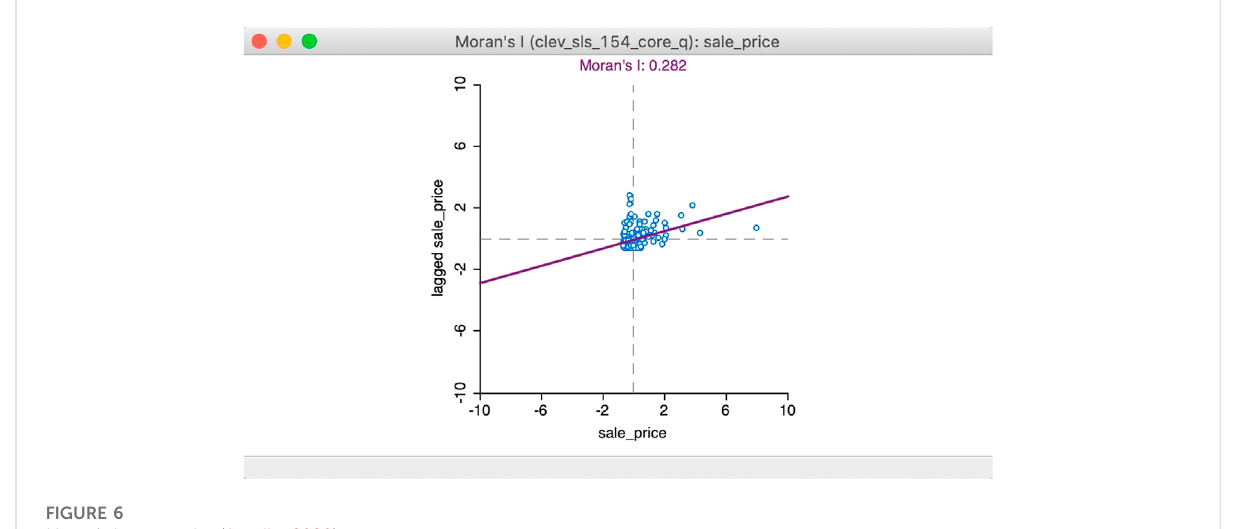
FIGURE 6 Moran ’ s I scatter plot (Anselin,